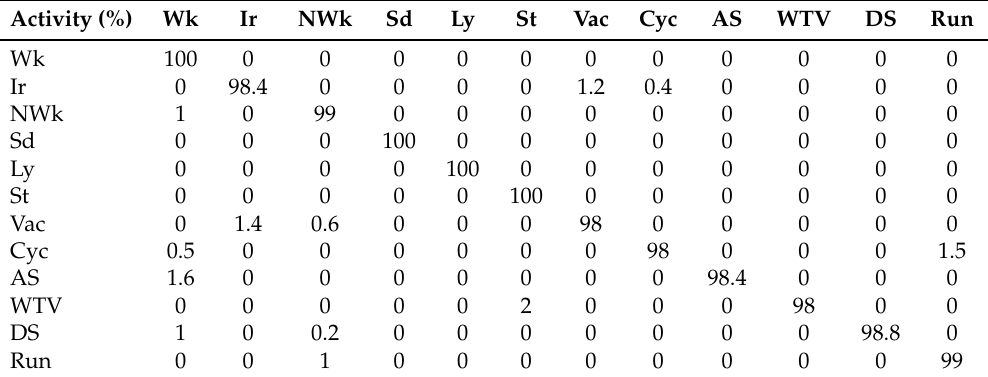
Table 6. Confusion matrix of the CNN-BiGRU model.